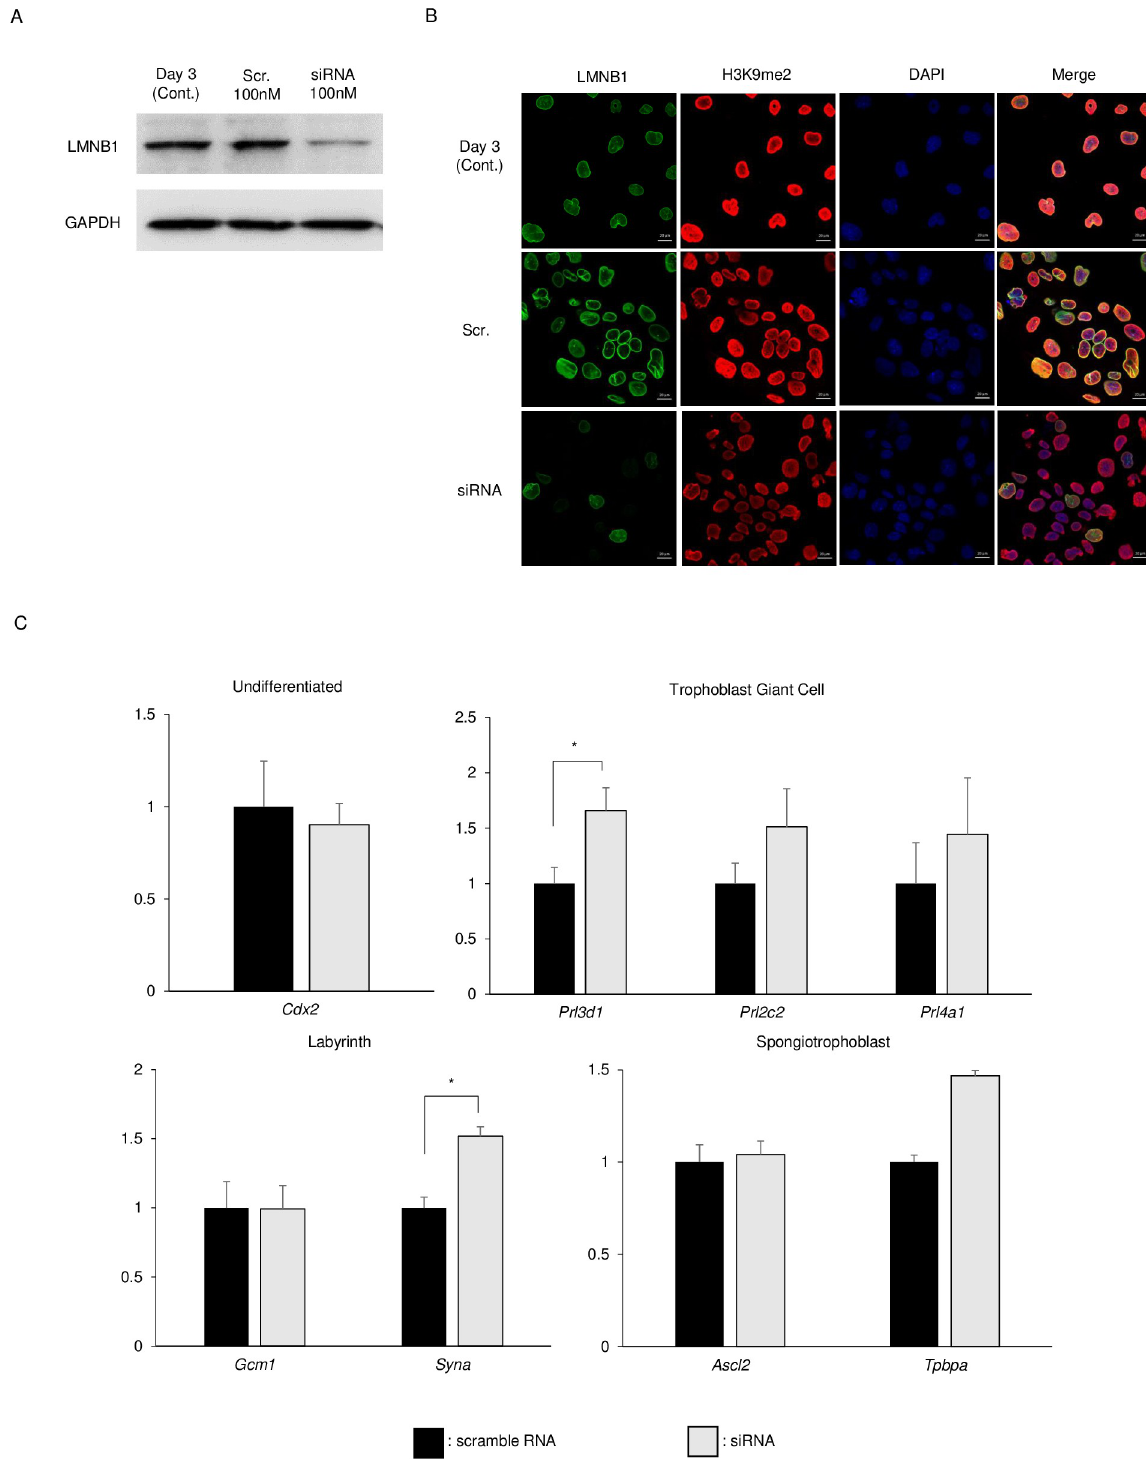
Fig 4. Knockdown of Lmnb1 in TGCs by siRNA. siRNA-transfected TSCs were cultured for 3 days in TS medium without Fgf4. LMNB1 protein was then detected by western blotting (A), and the localization of LMNB1 and H3K9me2 was detected by immunostaining. (C) Expression levels of undifferentiated gene ( Cdx2 ), trophoblast giant cell markers ( Prl3d1 , Prl2c2 , and Prl4a1 ), labyrinth markers ( Gcm1 and Syna ), and spongiotrophoblast markers ( Ascl2 and Tpbpa ) were examined by qRT-PCR. Expression levels were normalized with Gapdh . The data are presented as means ± SE (n = 3). Significance was determined by the t -test. � Indicates P < 0.05 compared to scramble RNA.